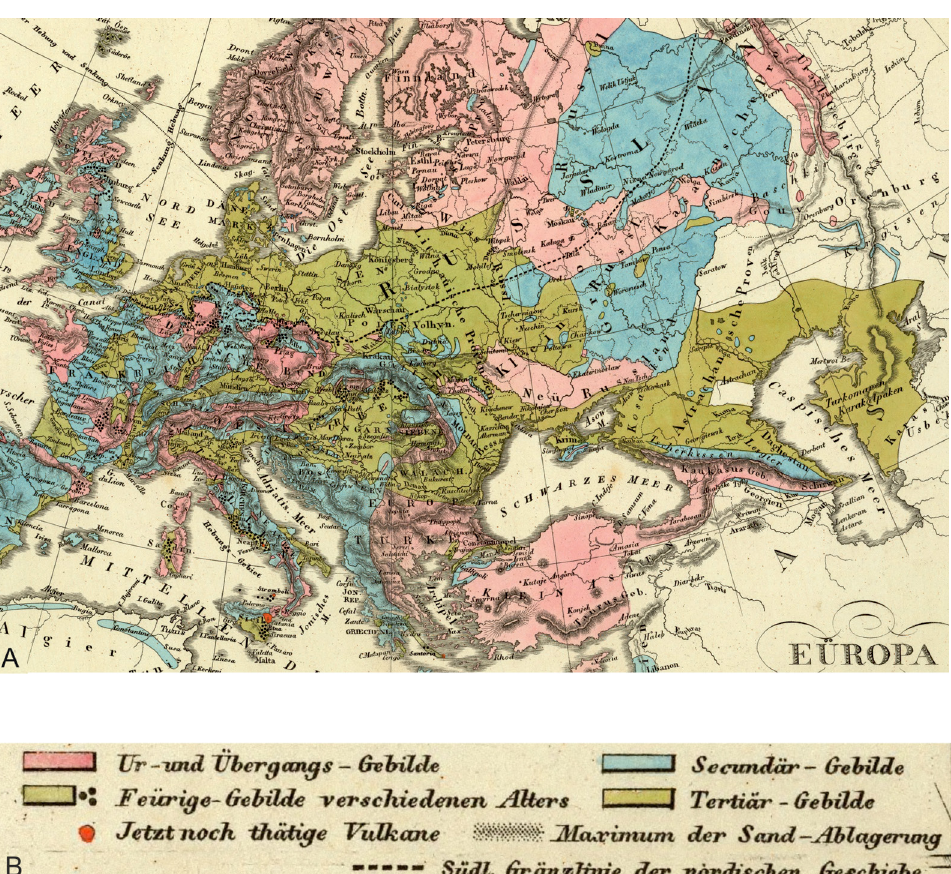
Fig. 9. Part of the map Europa in Geologischer Beziehung by H.K. Berghaus − A and its explanation − B (from the David Rumsey Map